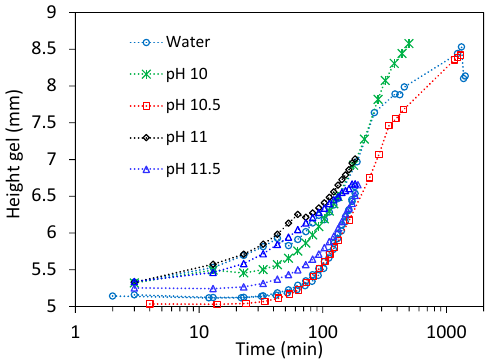
Figure 3. Height increase measured from the estimated contact point in swelling experiments at low alkaline pH or in water. Notice the significant variability of the dynamic swelling process between the several repeats shown, which masks the effect of the solution pH.